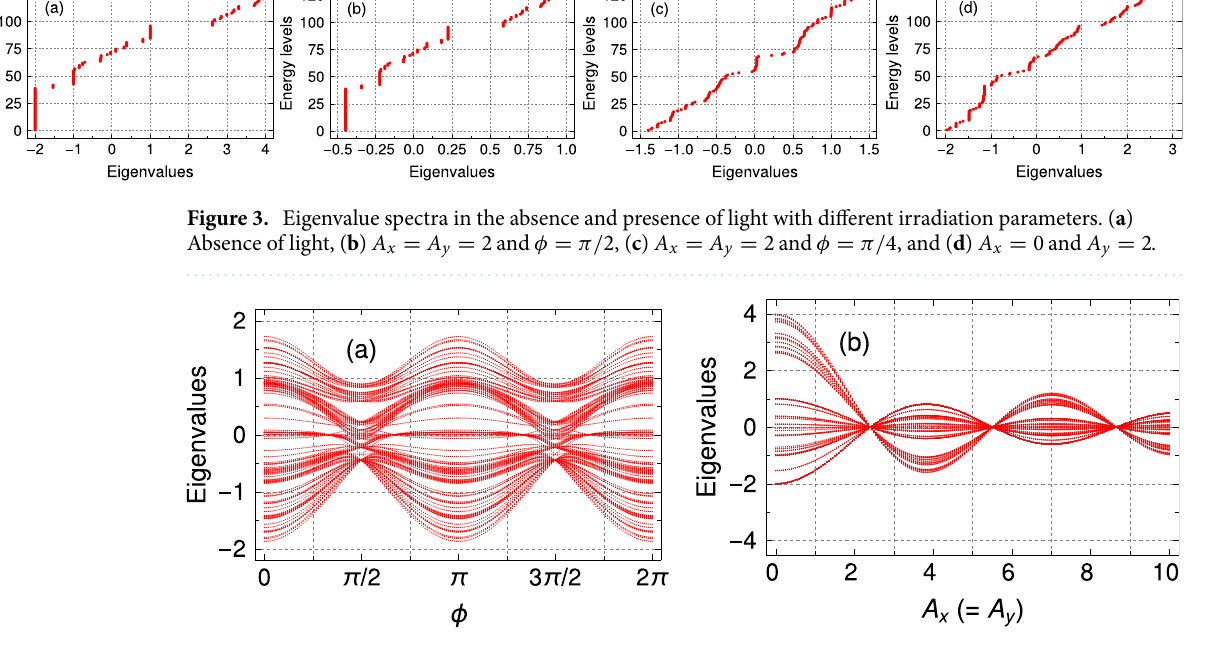
2 and ( b ) field amplitude A A y = =